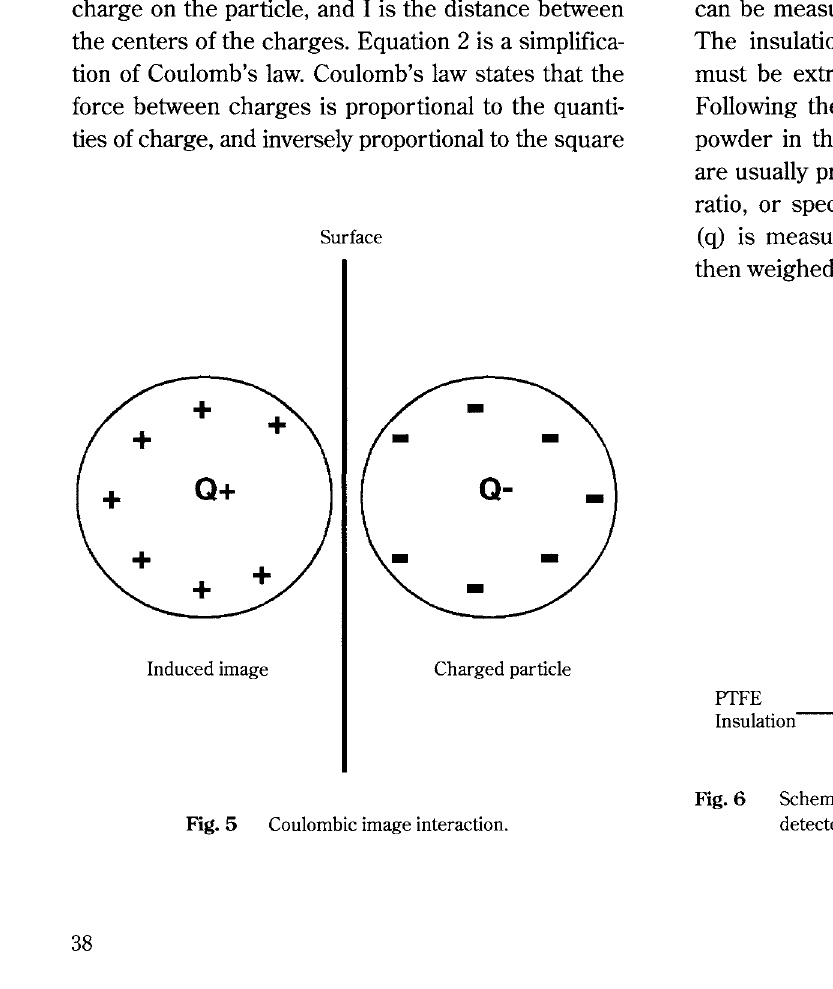
Fig. 5 Coulombic image interaction.